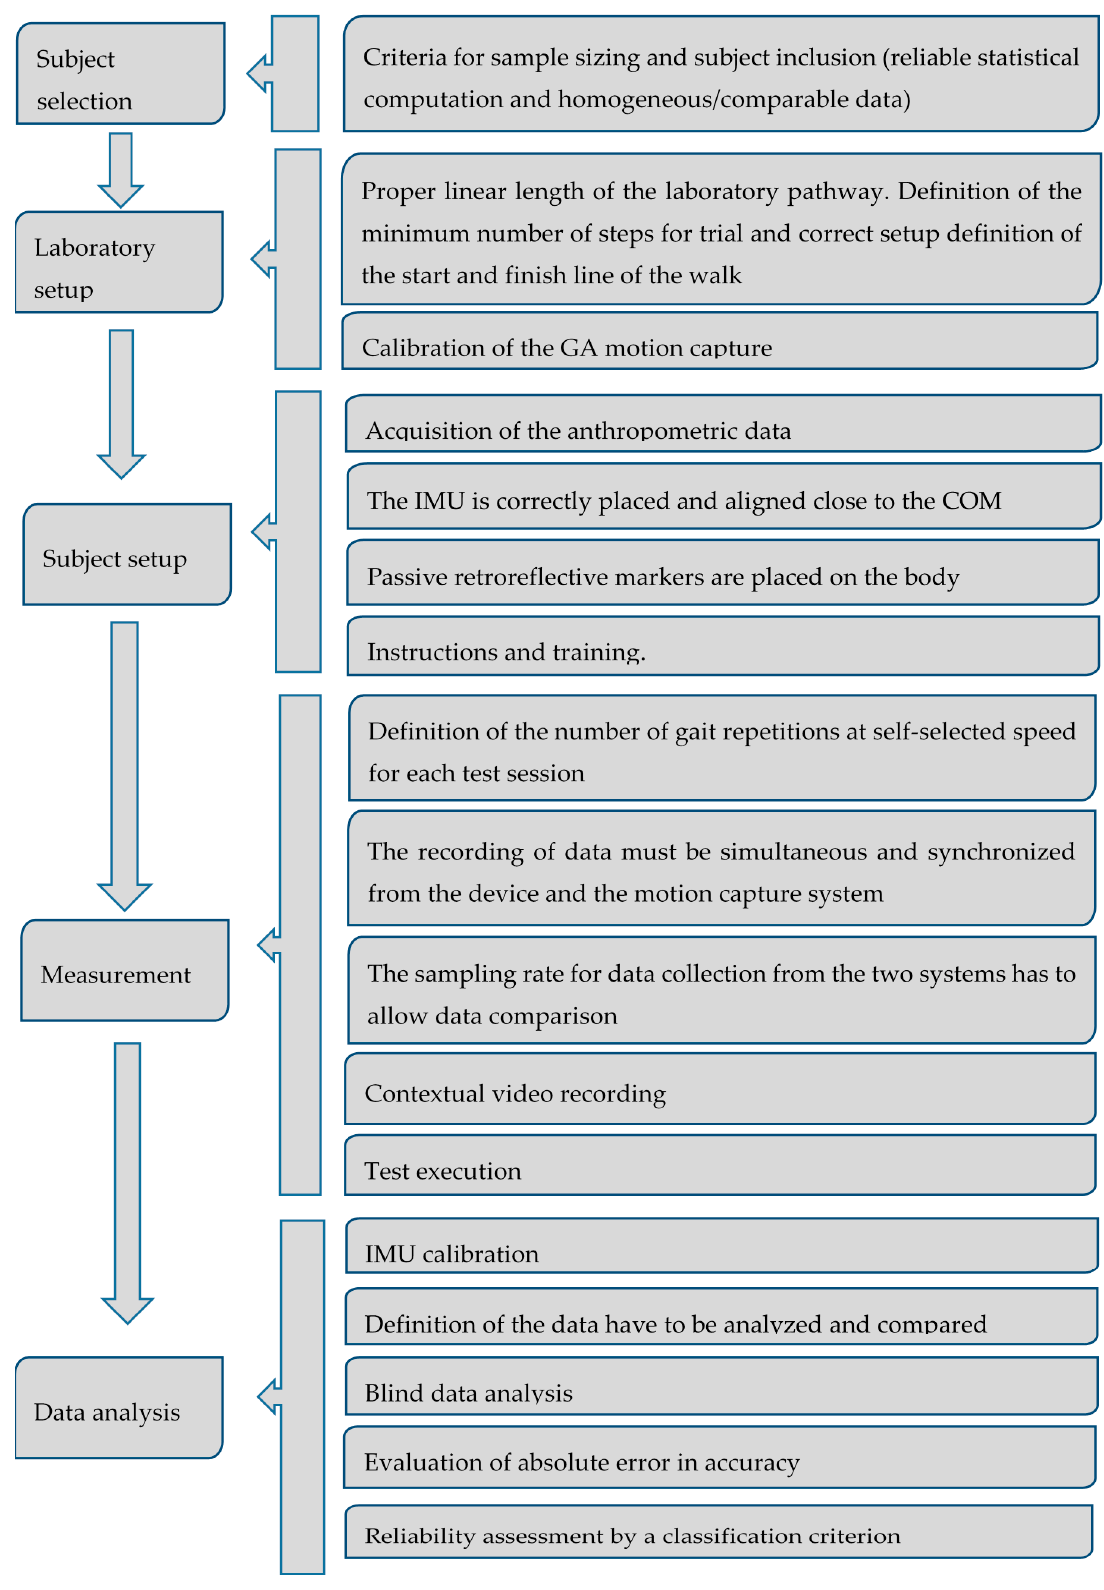
Figure 1. The flow chart relative to protocol design guidelines.